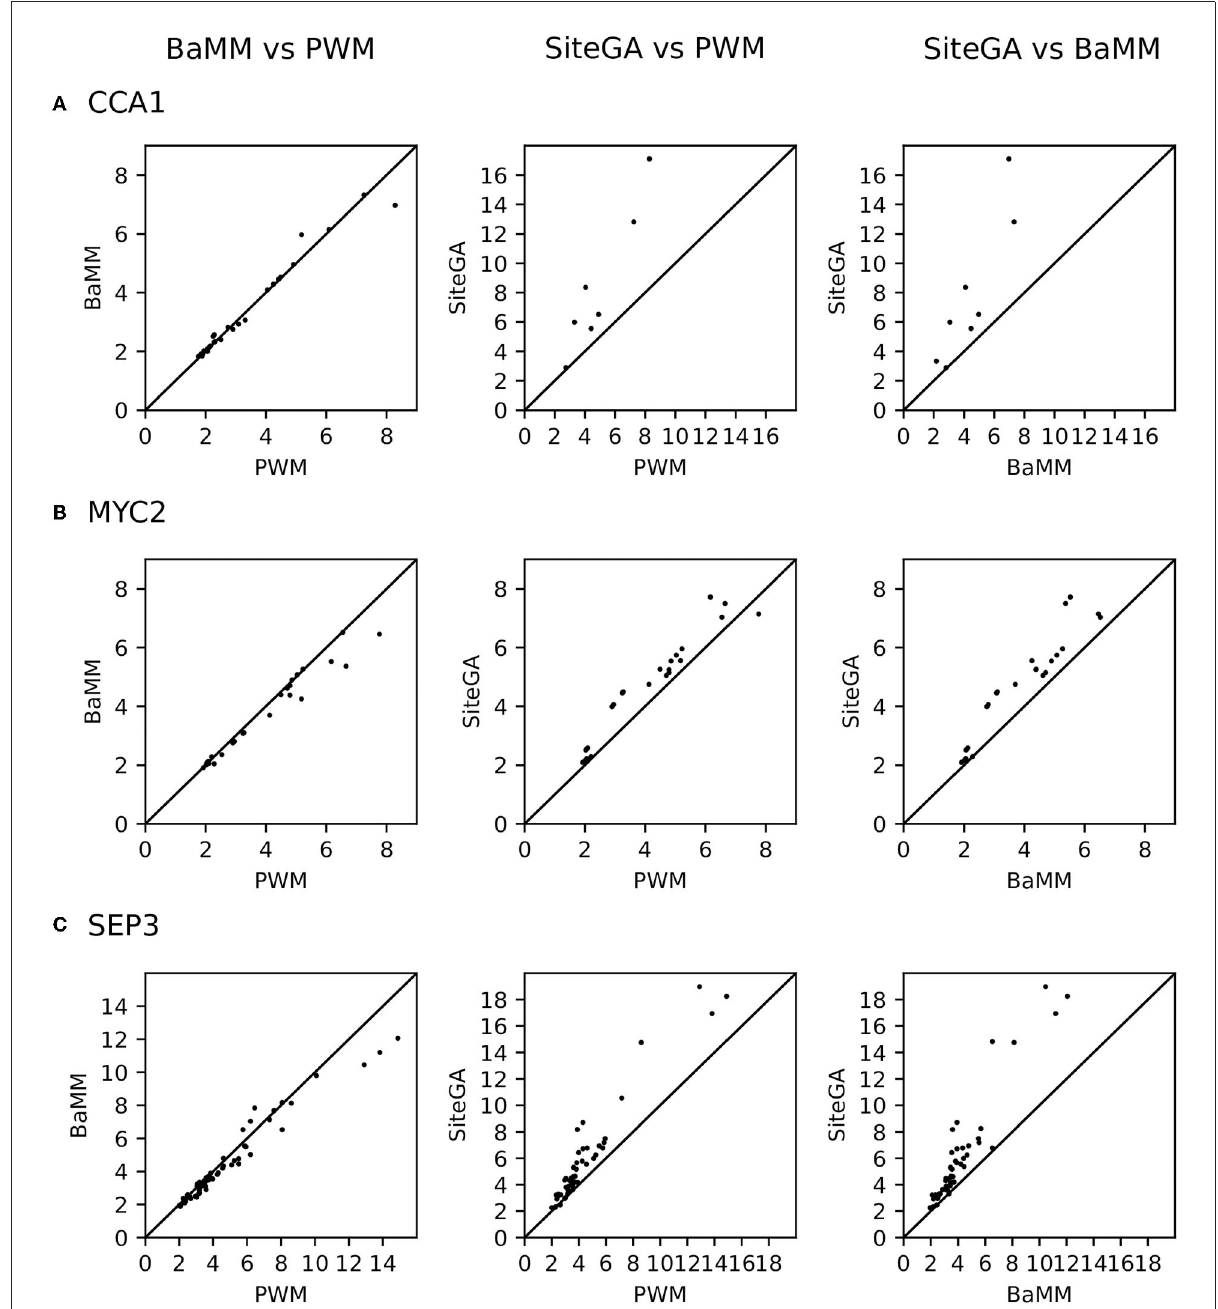
FIGURE7 Efficiency of PWM, BaMM, and SiteGA models in terms of the portions of genes with the significantly enriched GO terms among all genes with predicted sites. (A–C) Show CCA1, MYC2, and SEP3 datasets, respectively. Axes in all scatterplots imply the fold enrichment respecting the predictions of models (see Table 1 and Section 2). For each dataset, we included in analysis the same set of the GO terms; each GO term possessed the significance of enrichment ( p _adj < 0.05) for three motif models